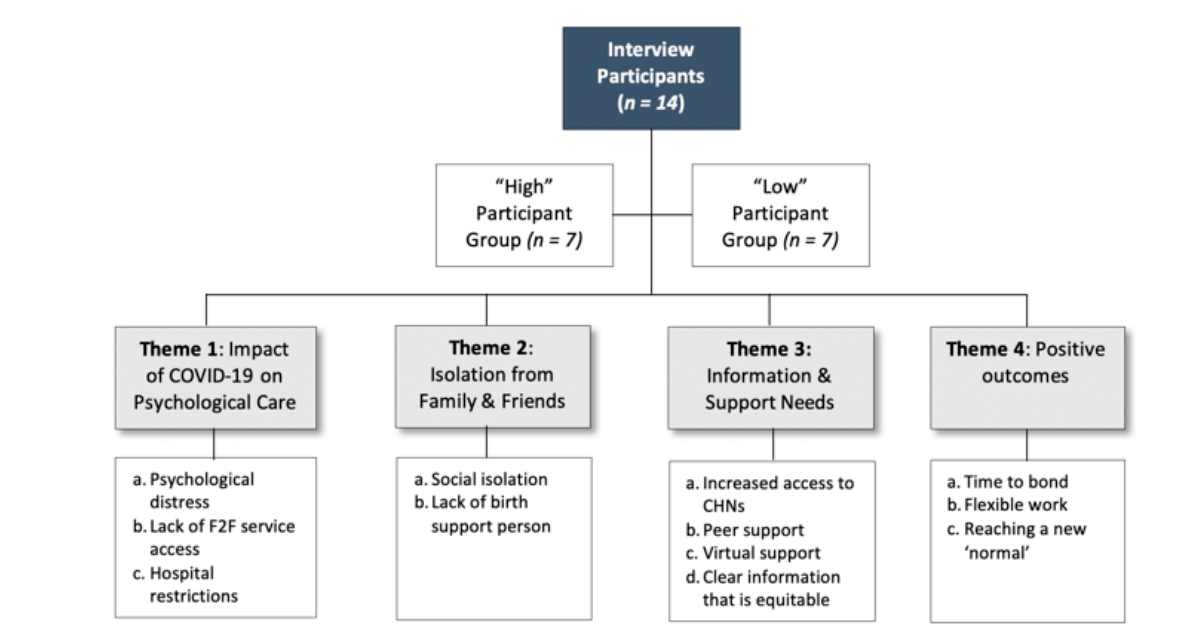
Figure 5. Key Qualitative Themes from both the “High” and “Low” Groups.